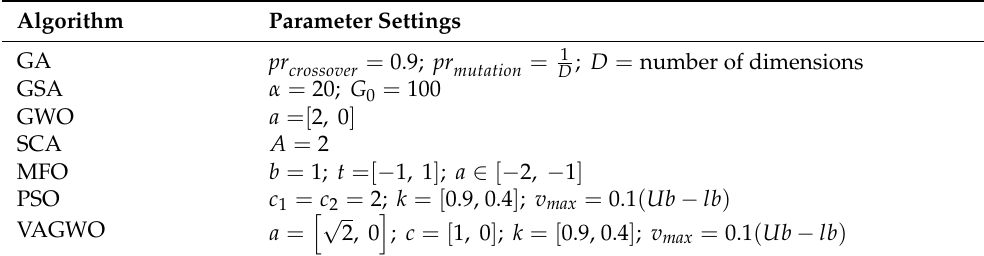
Table 1. Parameter settings of the VAGWO and the popular